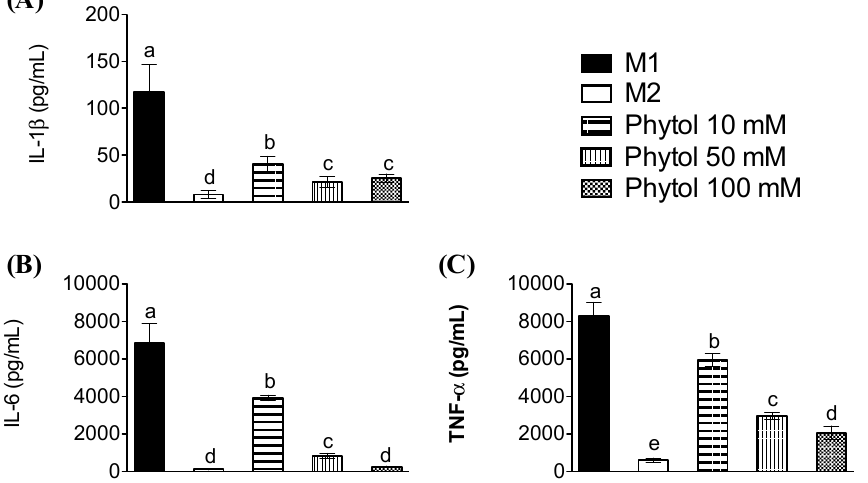
Figure 4. Effect of phytol on the release of pro-inflammatory cytokines. Cells from M0 macrophages were incubated in the presence of LPS and IFN γ , for M1 control, or with IL-4 for the M2 control, or with 10–100 mM Phytol for an additional 24 h. Using ELISA protocols, in polarized macrophage culture supernatants, the concentrations of ( A ) IL-1 β , ( B ) IL-6, and ( C ) TNF α were measured. The values are means ± SD (n = 3) and, if marked with different letters, they are significantly different ( p < 0.01).